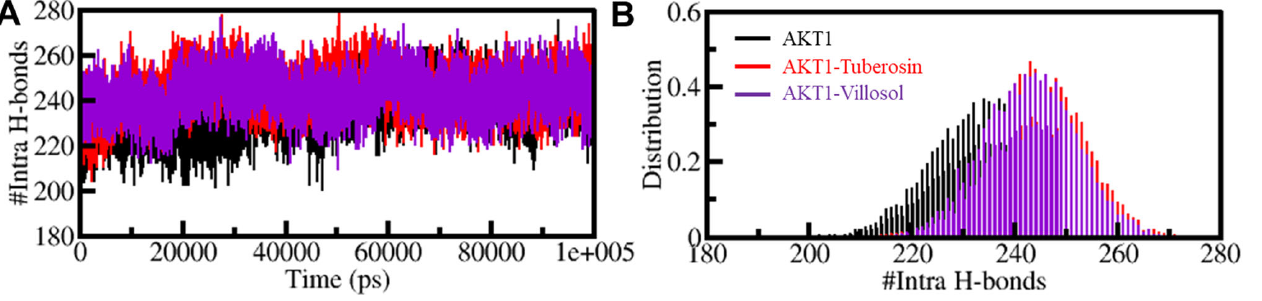
Figure 5. Formation of hydrogen bonds in time evolution plot formed within 0.35 nm of intra-AKT1 (panel on the left). The probability density function (PDF) of the intramolecular hydrogen bonds present within the structure of AKT1 (panel on the right).